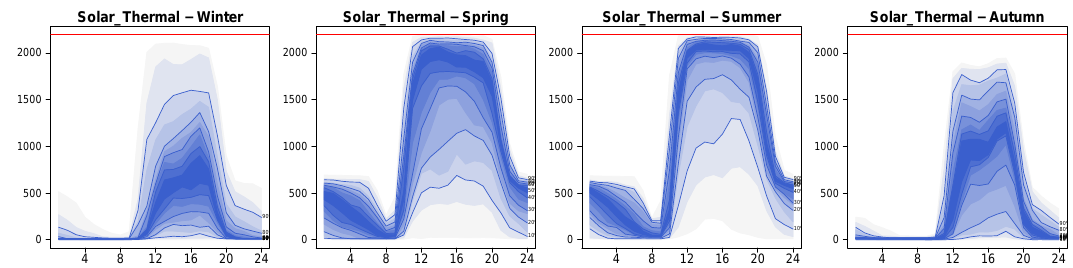
Figure 3. The Solar Thermal generation seasonal pattern for 2017. Source: authors based on the data from REE [11].